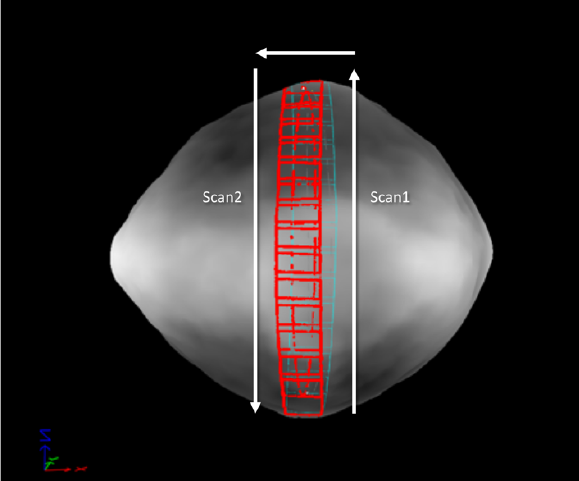
Figure 4: Example of science observation planning for the global panchromatic basemap with the J-Asteroid geospatial information system (Christensen et al., 2018). Shown are the first two image scans for Flyby 3 in the Detailed Survey: Baseball Diamond subphase of the mission. Scan 1 (in blue) was acquired as the spacecraft slewed from south to north. Scan 2 (in red) follows immediately in the opposite direction. Ninety-two scans were acquired for Flyby 3 to achieve global